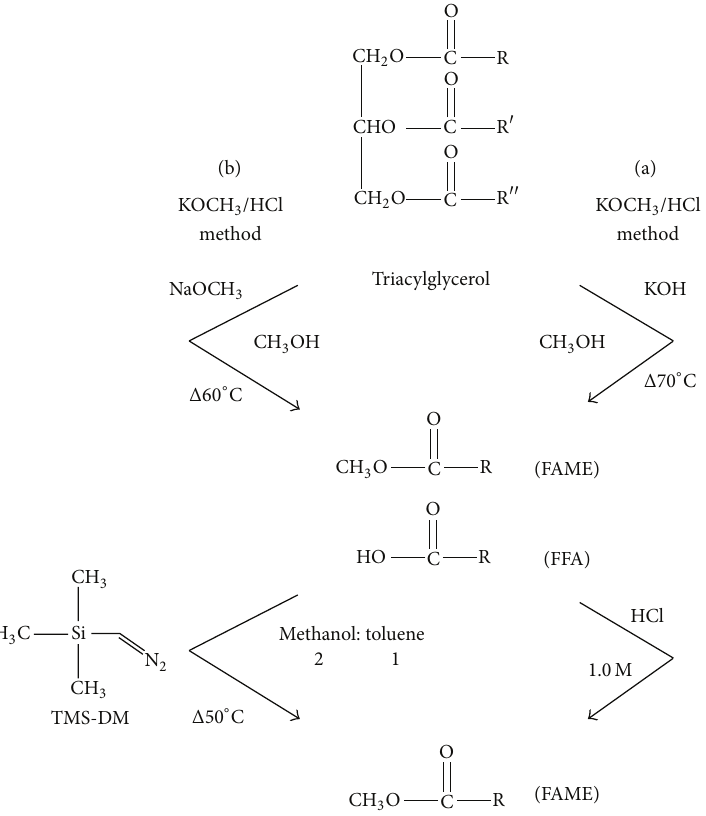
Figure 1: Diagram for the procedures of the method (a) (KOCH 3 /HCl) and method (b) (TMS-DM). a solution containing 10 mg/5 mL (C15:0) in methanol